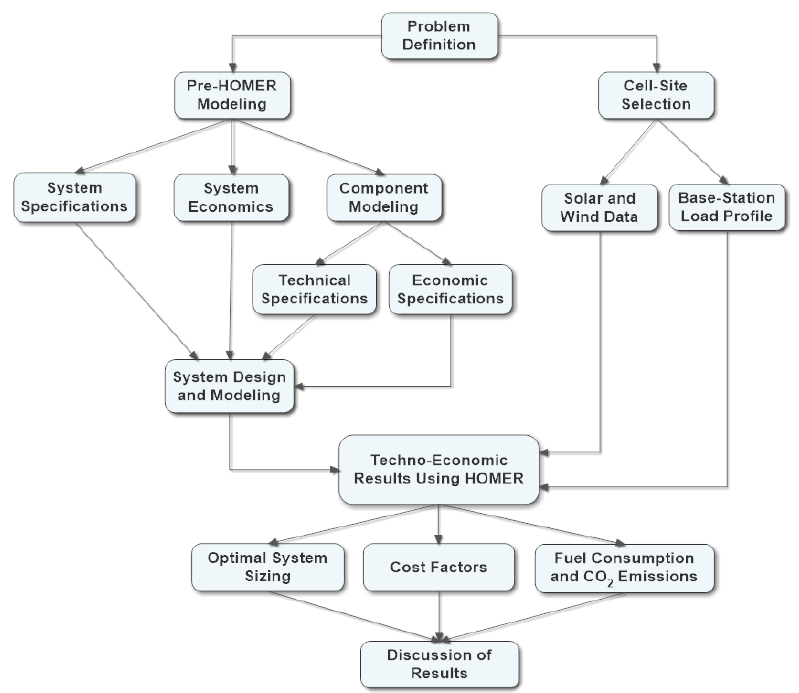
Figure 2. Modeling and